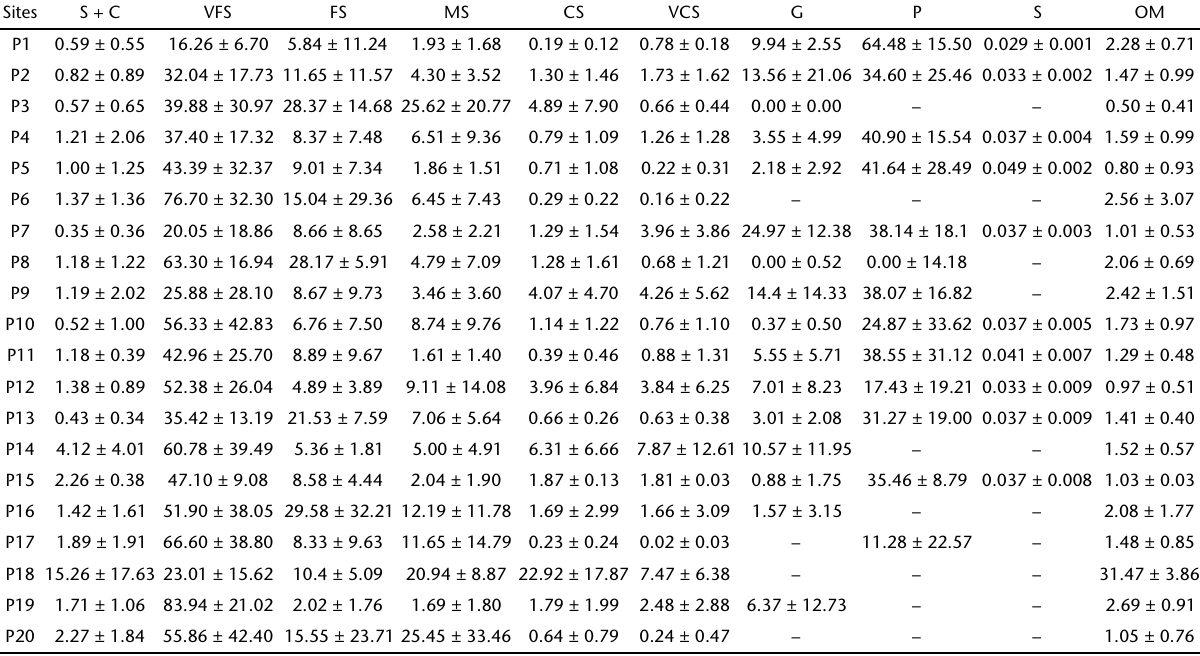
Table II. Average values and standard deviations of the sediment variables evaluated in 20 sites along the Pandeiros River Basin. Granulometric fractions were silt + clay (S + C), very fine sand (VFS), fine sand (FS), medium sand (MS), coarse sand (CS), very coarse sand (VCS), gravel (G), pebbles (P), stones per cubic meter (S), and the percentage of organic matter (% OM).